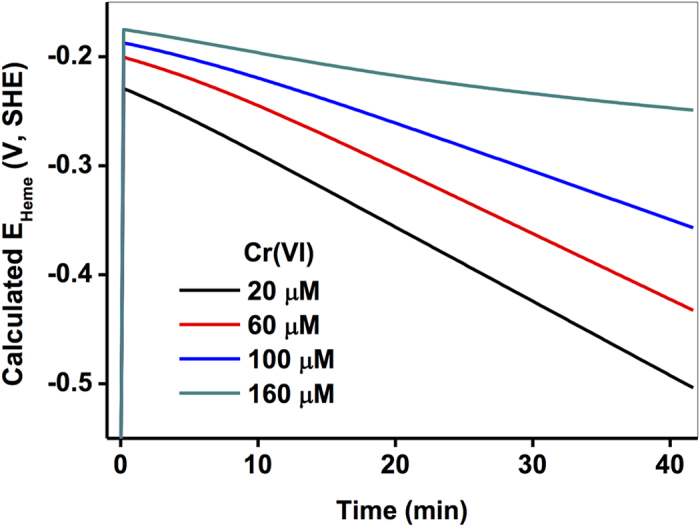
Calculated specific redox potentials of EHeme of SP200 with 20 μM – 160 μM mg L−1 of Cr(VI). The solid lines were calculated from fitting curves for Hemered in Fig. 3b and reactive Hemeox in Fig. 3c based on Eq. 11.